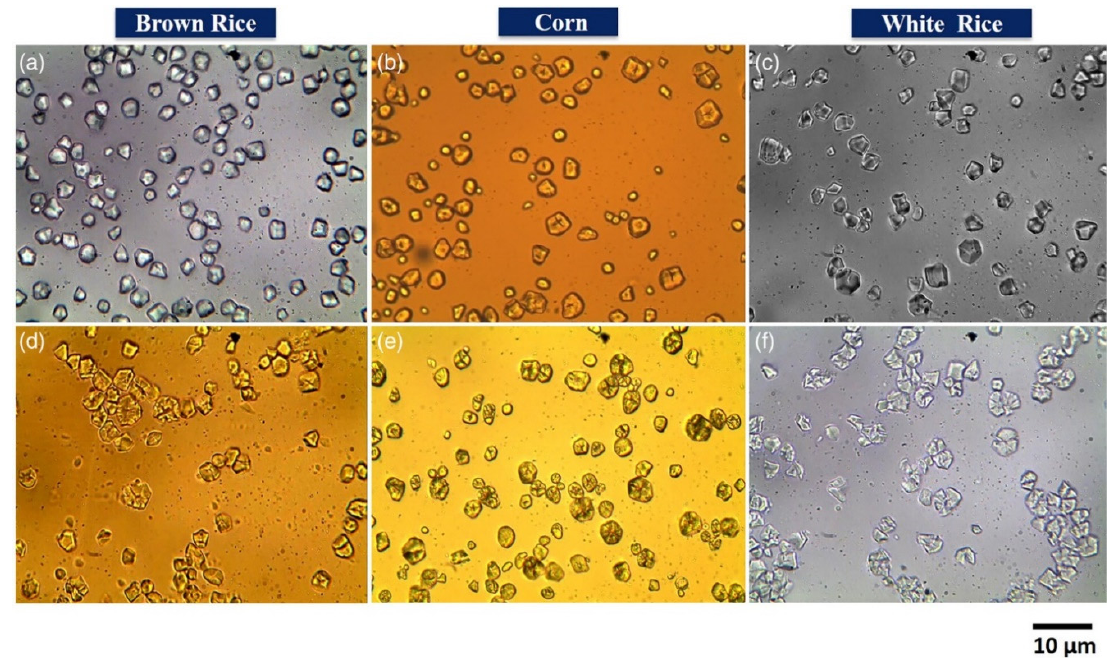
Figure 3. Optical microscopic (40× magnification) images of starch granules of native ( a ) brown rice, ( b ) corn, and ( c ) white rice. Hydrolyzed ( d ) brown rice, ( e ) corn, and ( f ) white rice [67]. (Reprinted with permission from Govindaraju et al., 2020.)